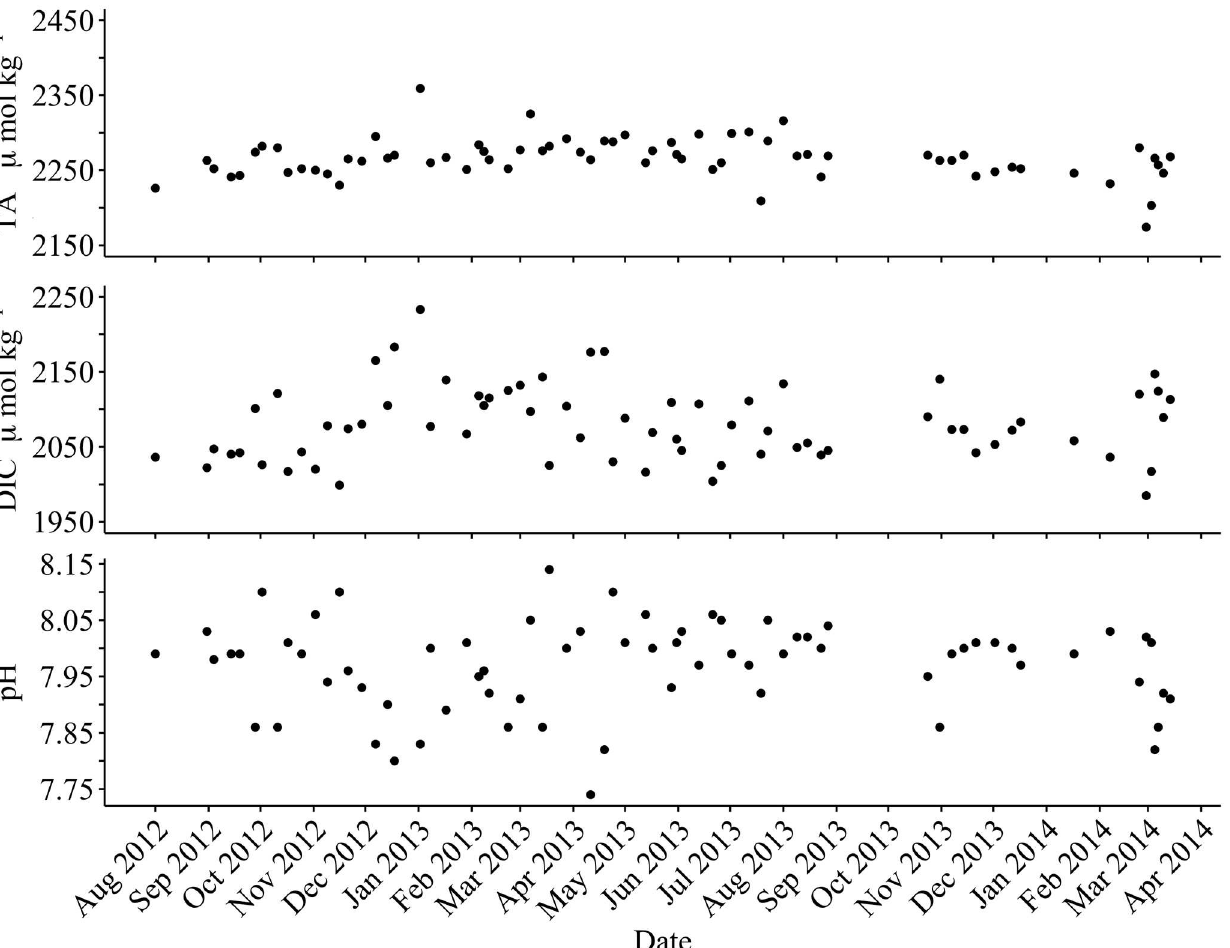
Fig 1. Carbonate systemvariability at Stearns Wharf. Variabilityin carbonate system parameters(TA, DIC, in situ pH) collectedat Stearns Wharf betweenAugust 2012 and April 2014.